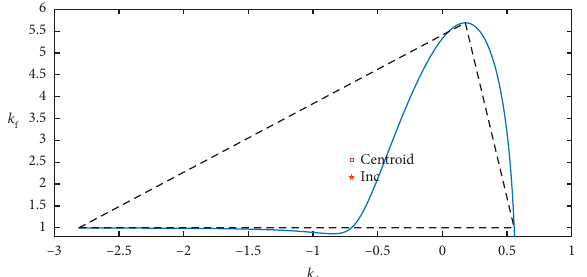
Figure 13: General corner point of inner-loop PD controller in example D.